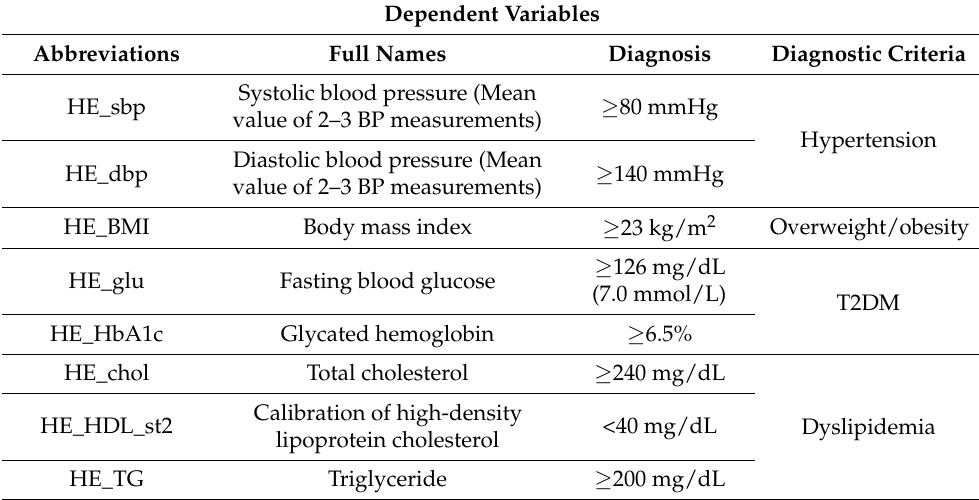
Table 2. Classification of dependent